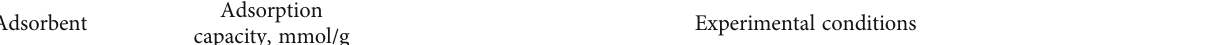
Table 3: Adsorption capacities of CSK6 sample and other adsorbents reported in the literature for the separation of itaconic acid [5]. Adsorbent